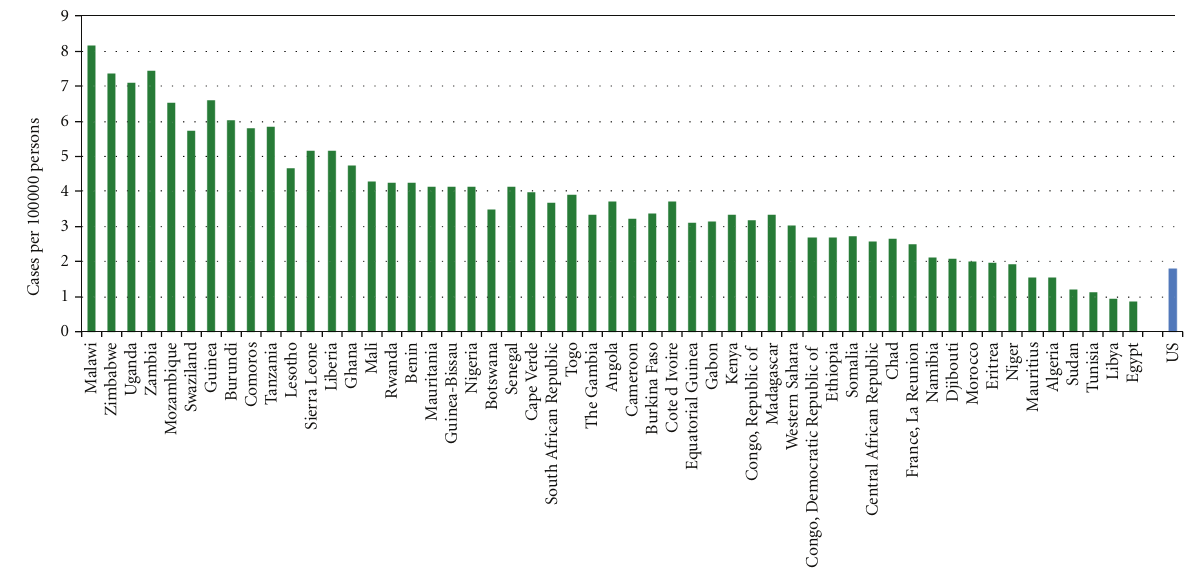
Figure 2: Incidence of non-Hodgkin lymphoma in Africa compared to the United States. Data courtesy of GLOBOCAN